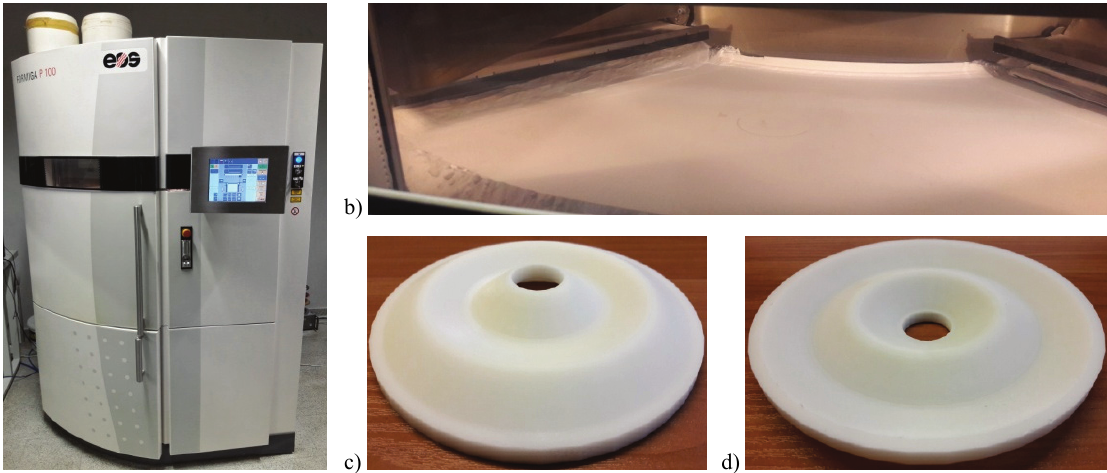
Fig. 6. 3D printing: a) Formiga P100 3D printer, EOS GmbH, b) production